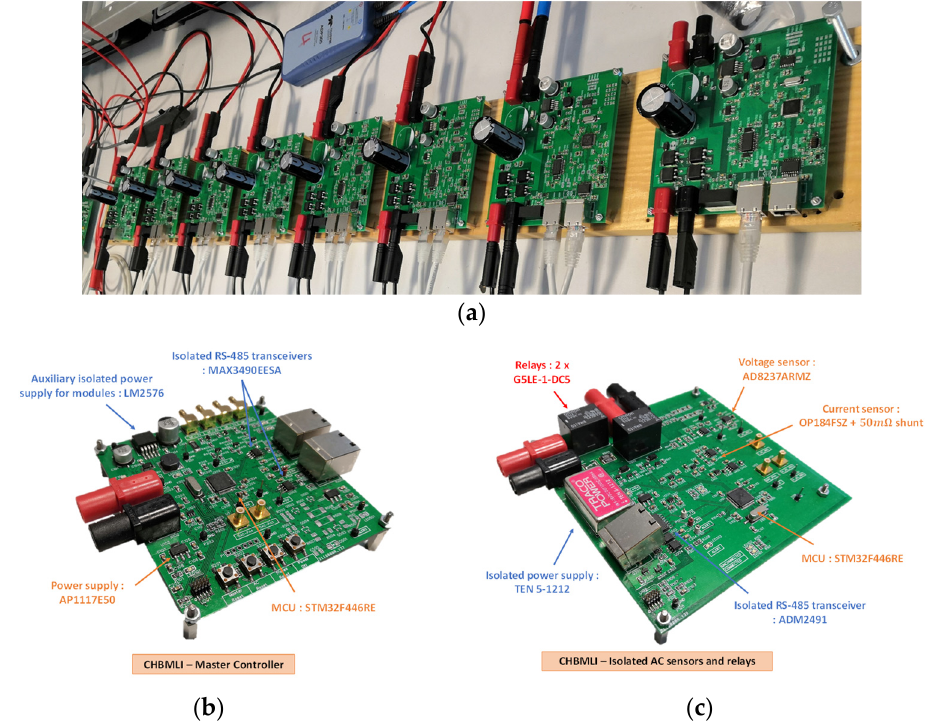
Figure 8. ( a ) Experimental setup of the Cascaded H-Bridge Multilevel Inverter with eight modules ( b ) Master controller of the CHBMLI ( c ) Circuit with isolated AC sensors and relays for the CHBMLI.